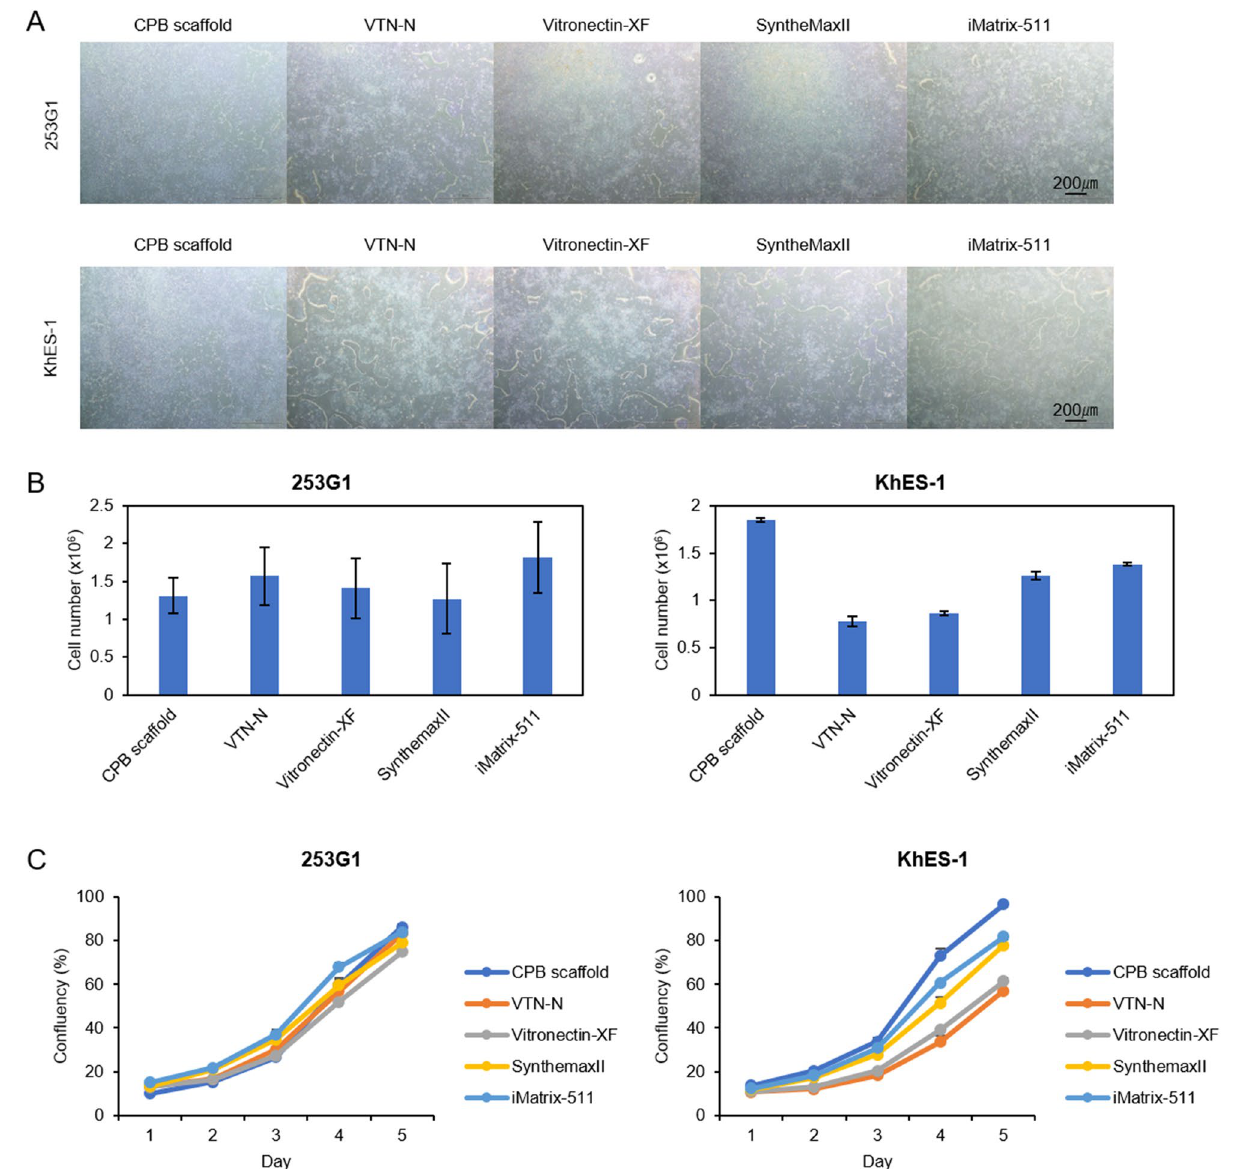
Figure 4. Comparison of CPB scaffold with other commercially available substrates. ( A ) 253G1 and KhES-1 colony morphology on various substrates at 5 days in Essential 8 medium. All scale bars are 200 µm. ( B ) Cell number of 253G1 and KhES-1 at five days of culturing in Essential 8 medium after seeding 5 × 10 4 cells on various substrate. ( C ) Cell proliferation curves of 253G1 and KhES-1 during 5 days of culturing in Essential 8 medium after seeding 5 × 10 4 cells on various substrates. Data are presented as mean ± SD of three independent